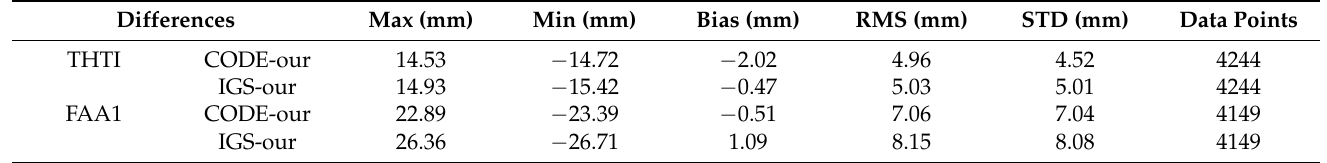
Table 2. Statistical summary for the comparison between our THTI/FAA1 ZTD estimates